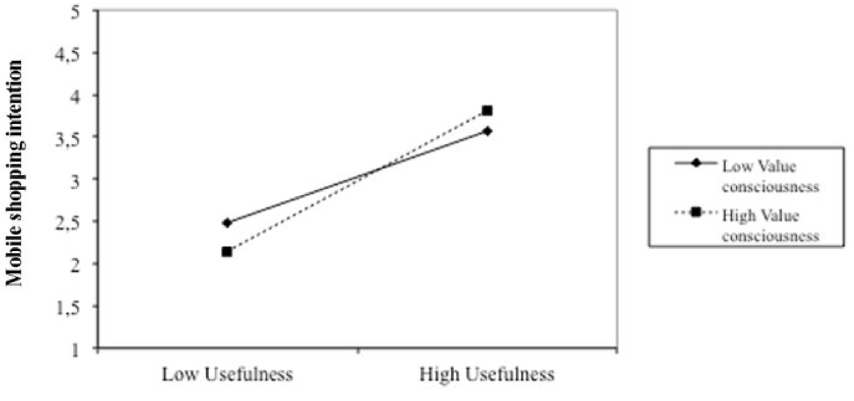
Figure 4. Relationship between